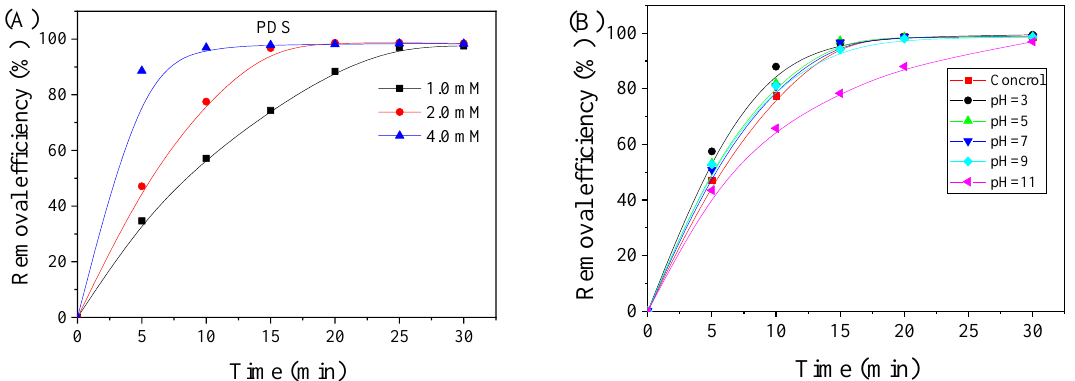
Figure 3. E ff ects of PDS dosage ( A ) and pH ( B ) on the removal e ffi ciency of Et-PABA using UV / PDS. Figure 3. Effects of PDS dosage ( A ) and pH ( B ) on the removal efficiency of Et-PABA using UV/PDS. Conditions: [Et-PABA] = 0.05 mM, [PDS] = 2.0 mM, and without pH Conditions: [Et-PABA] = 0.05 mM, [PDS] = 2.0 mM, and without pH adjustment.